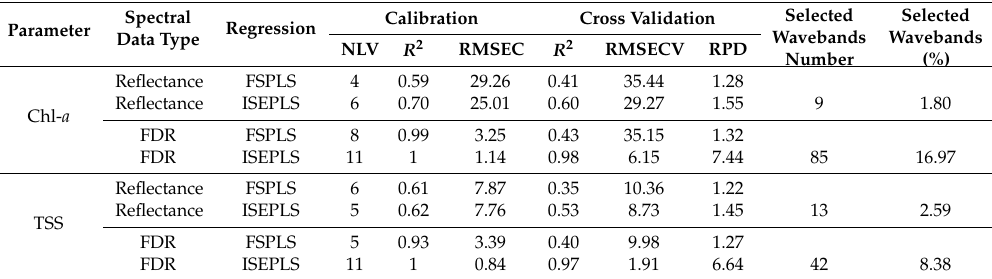
Table 4. Optimum NLV, R 2 and RMSECV using the LOO method in FS–PLS and in ISE–PLS using the entire dataset ( n = 36), with the residual predictive deviation, the number of selected wavebands and the percent ratio with respect to the full spectrum ( i =